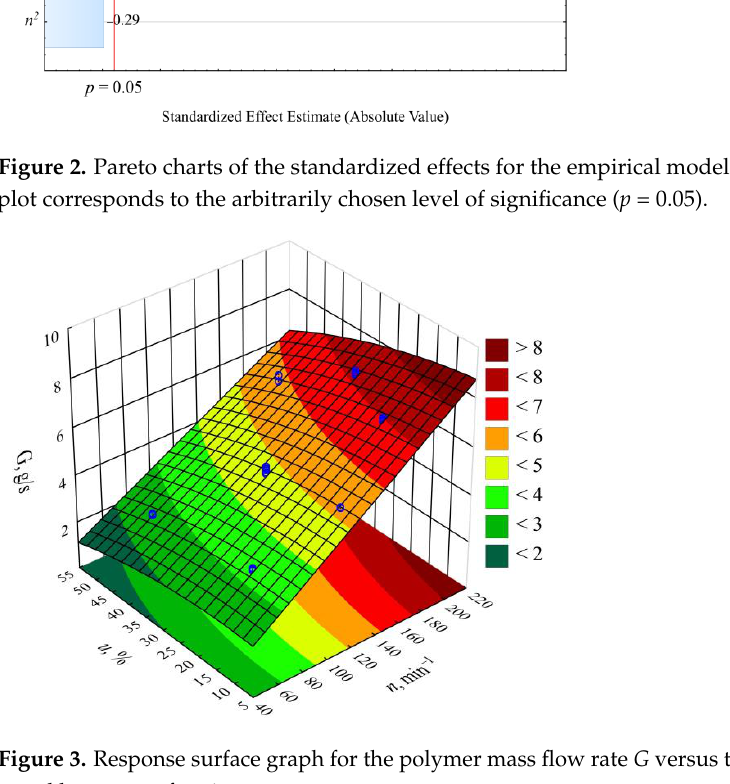
Figure 3. Response surface graph for the polymer mass flow rate G versus the screw rotational speed n and bran mass fraction u.